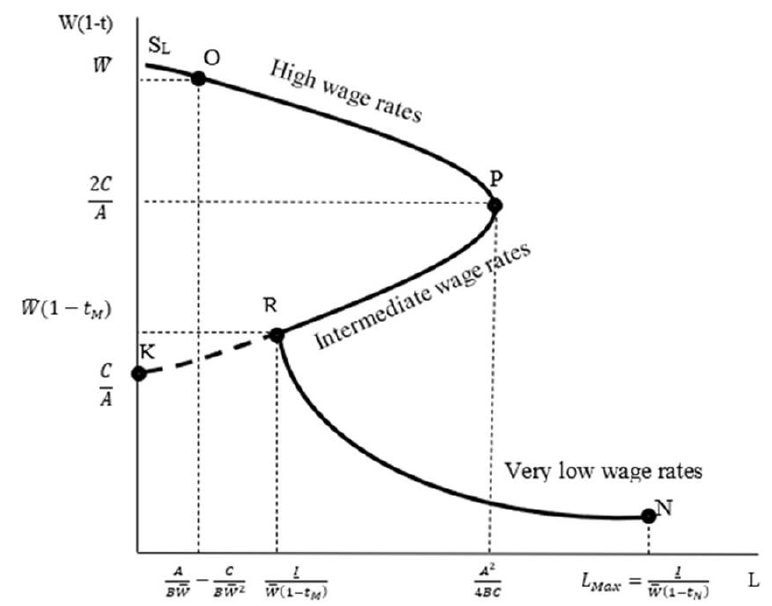
Figure 4. The inverted S-shaped labor supply